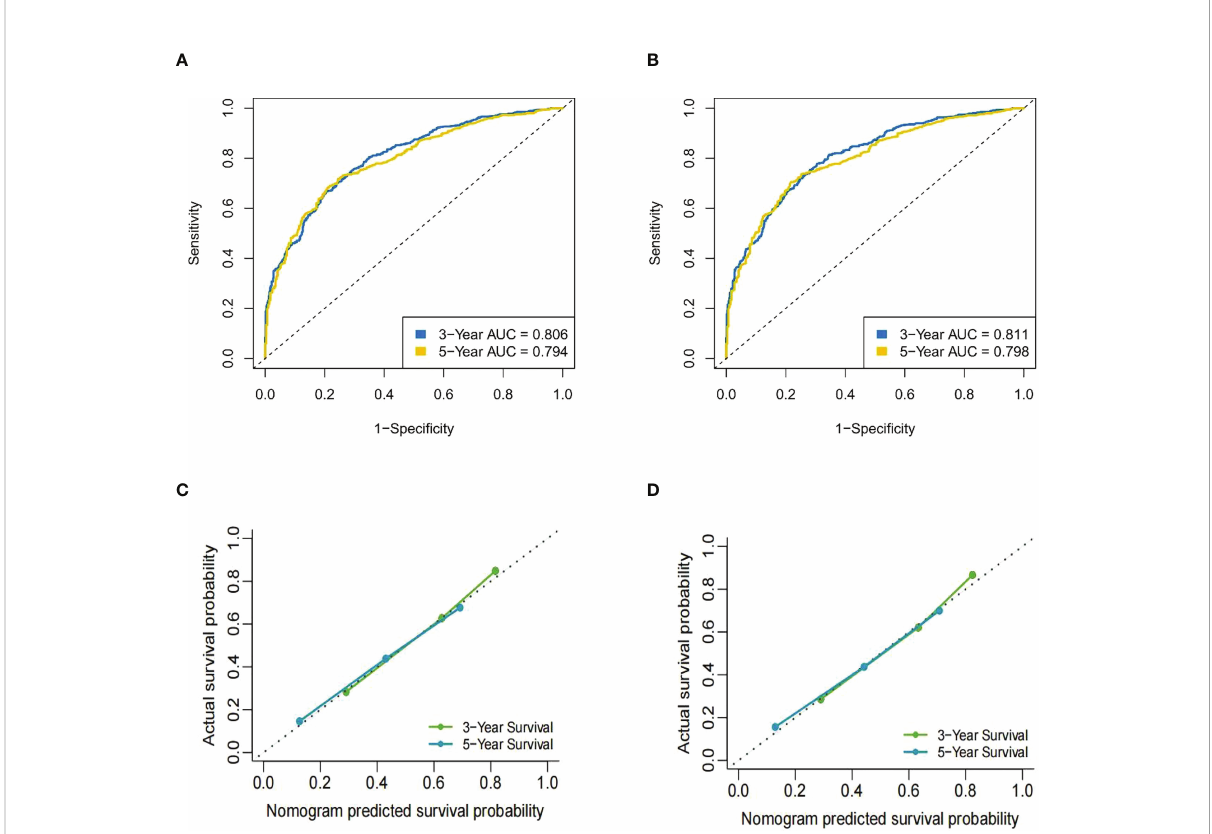
FIGURE 4 The ROC curve of the nomogram in the training cohort. (A) The AUC for OS at 3 years was 0.806 and at 5 years was 0.794. (B) The AUC for CSS at 3 years was 0.811 and at 5 years was 0.798. (C) The calibration curves for OS of the nomograms. (D) The calibration curves for CSS of the